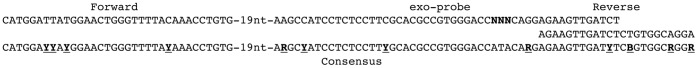
FMDV RT-RPA primers and exo-probe sequences aligned with the consensus sequence of 100 FMDV 3D genes downloaded from the Genbank.(Geneious® 6.1.5, Biomatters Limited, New Zealand). Mismatches are indicated in bold and underlined. The consensus sequence represents nt 7847–7961 of FMDV sequence JF749843. NNN are sites of the quencher and fluropohore in following order (BHQ1-dT) (Tetrahydrofuran) (FAM-dT). Y is C & T; R: A & G.